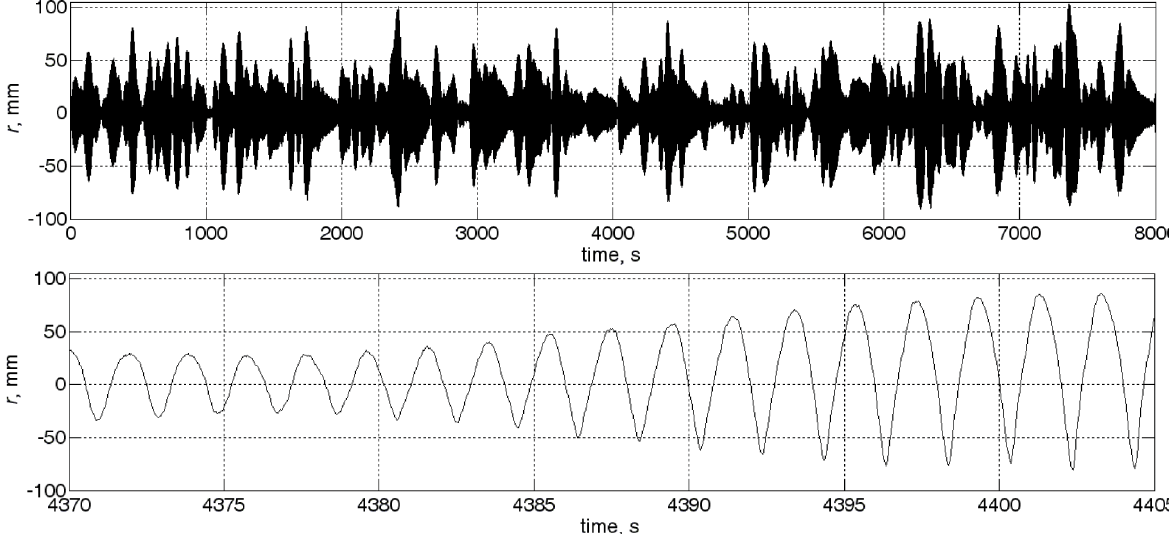
Fig. 6. Typical signals from the runup probe (top) and its zoom (bottom).